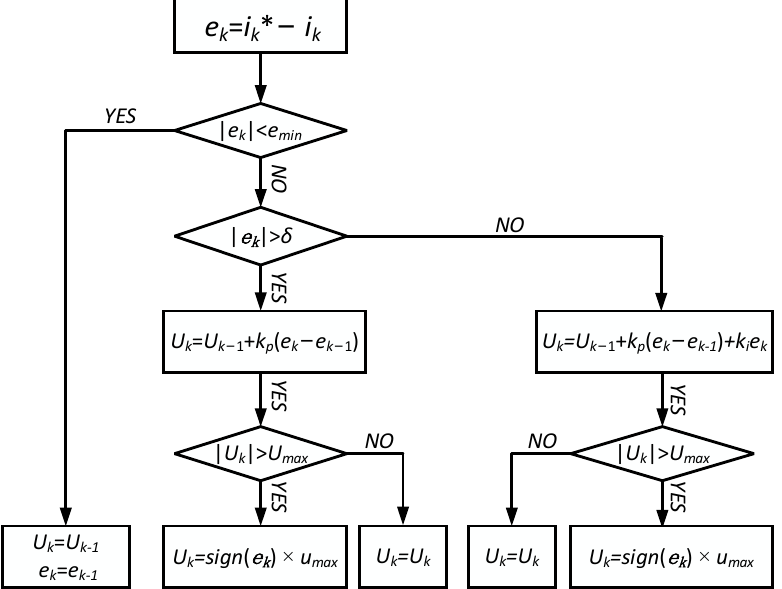
Figure 9. Flow chart of incremental PI control.